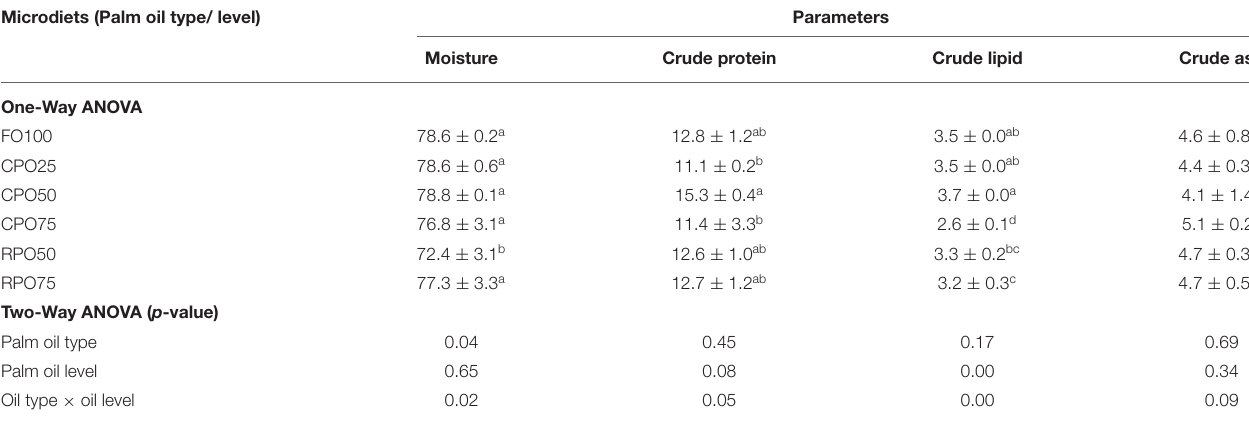
TABLE 4 | Whole-body proximate composition (% wet weight basis) of Asian seabass. Microdiets (Palm oil type/